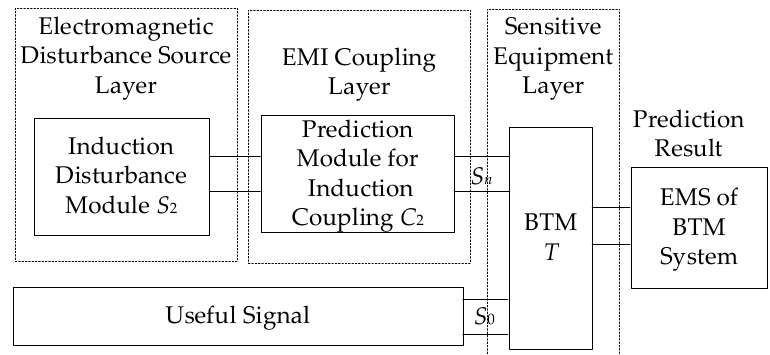
Figure 8. Model for Susceptibility Prediction of Balise-Based Train Control Systems.